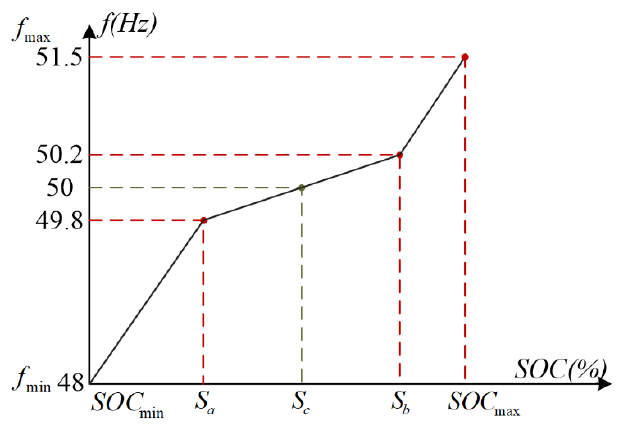
Figure 6. Frequency to SOC relationship.